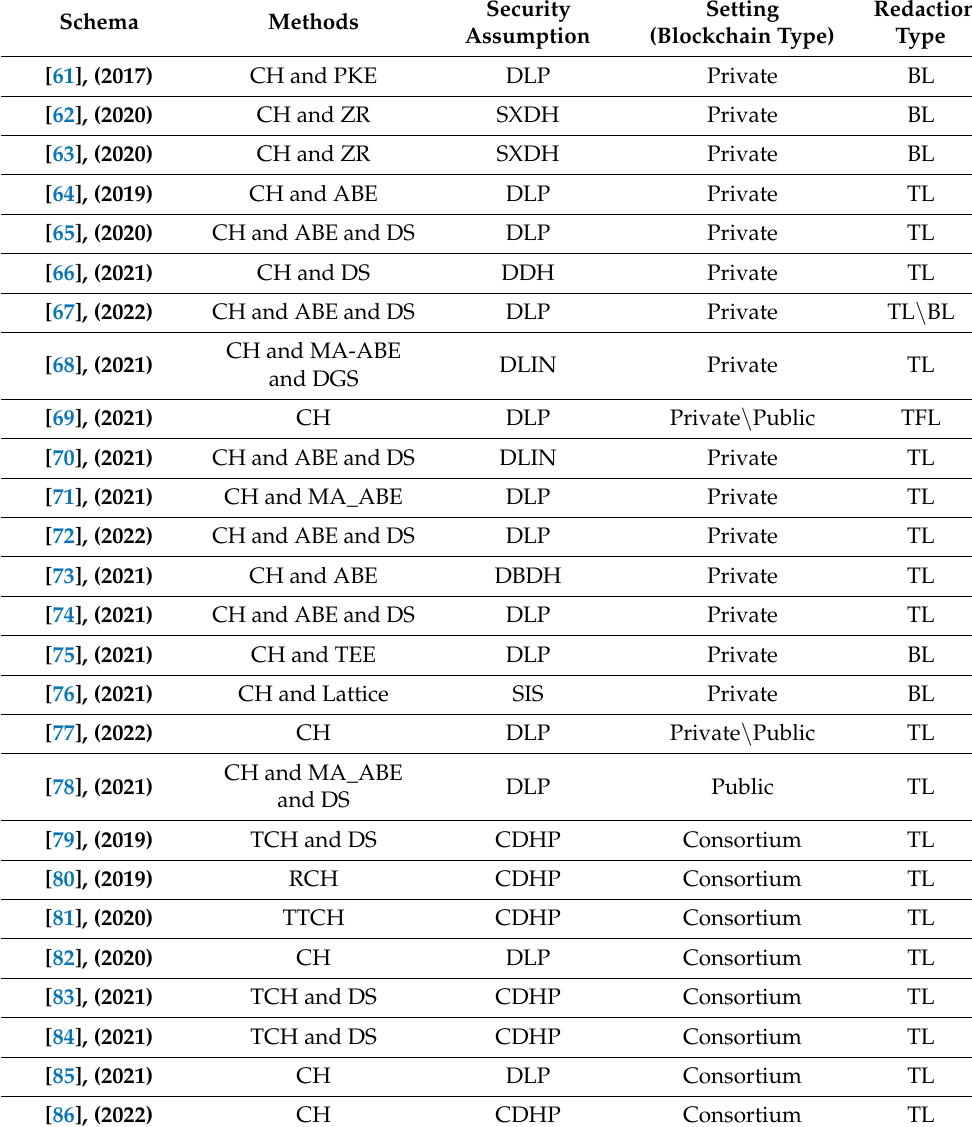
Table 2. Chameleon redaction methods